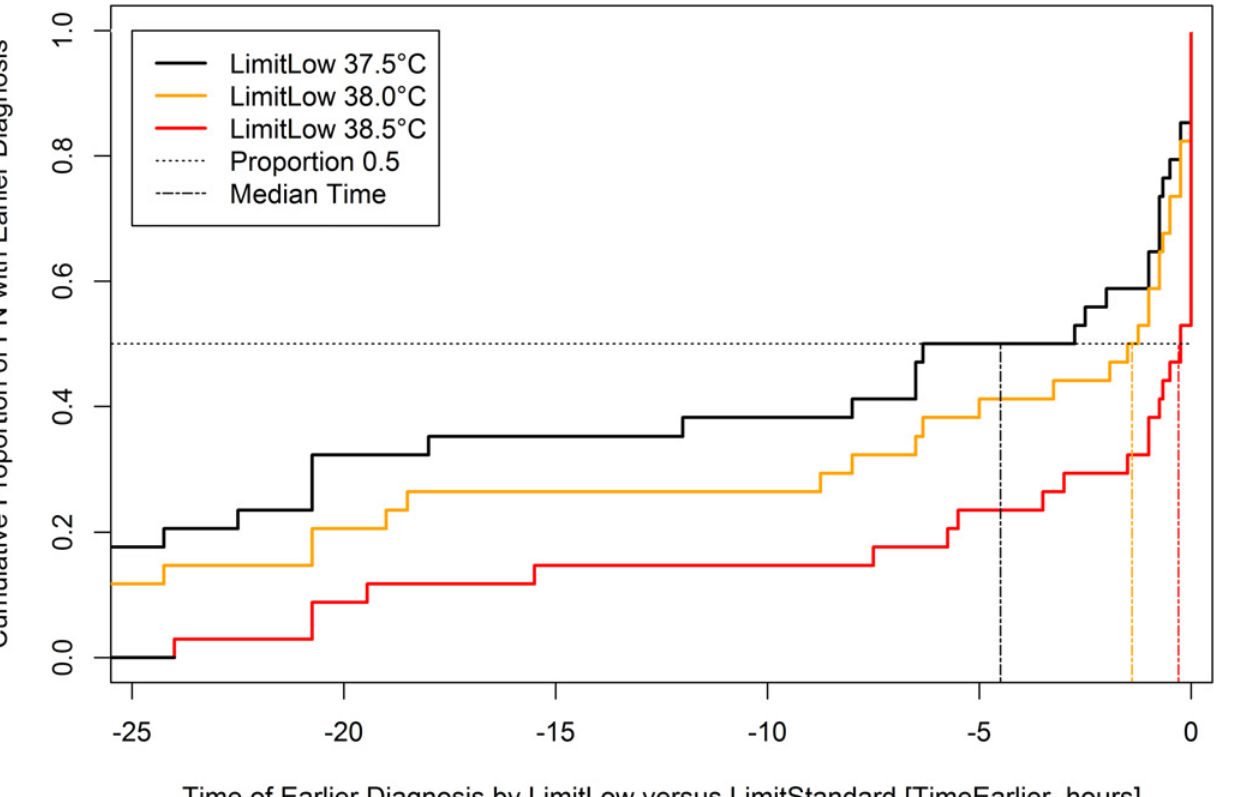
Figure 3. Cumulative proportion plots of Time Earlier at different Limit Low in 34 FN episodes diagnosed at Limit Standard